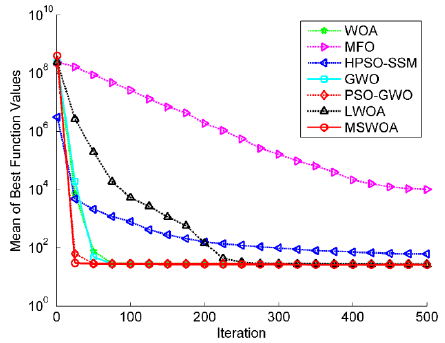
Figure 5. Optimization results for F3 (Dim = 30).